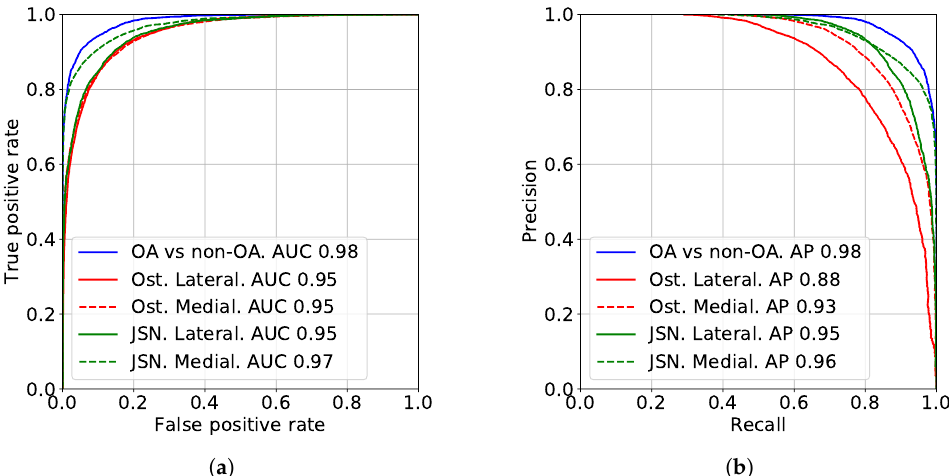
Figure 3. ROC and precision-recall curves demonstrating the performance of detecting the presence of radiographic OA (KL ≥ 2) osteophytes (grade ≥ 1) and joint-space narrowing (grade ≥ 1).